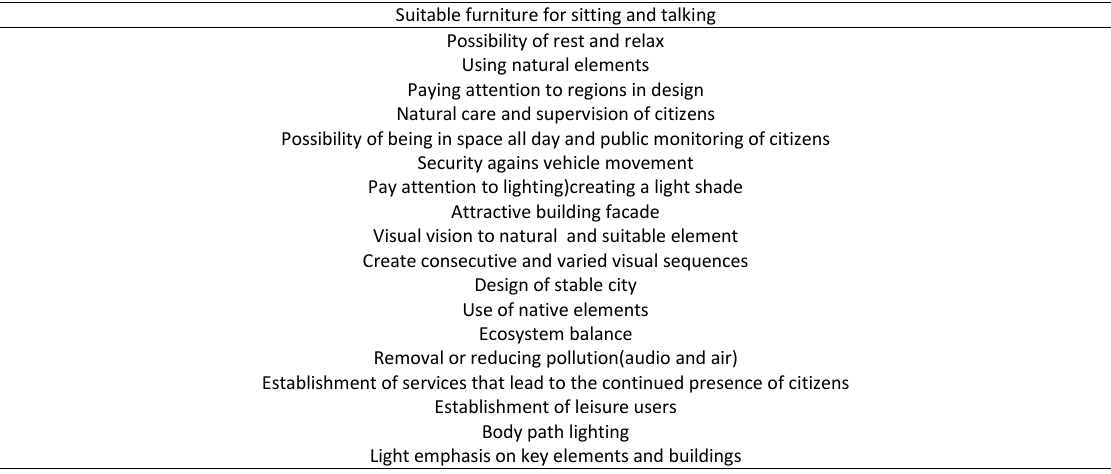
Table 3: Subdivisions of the physical dimension